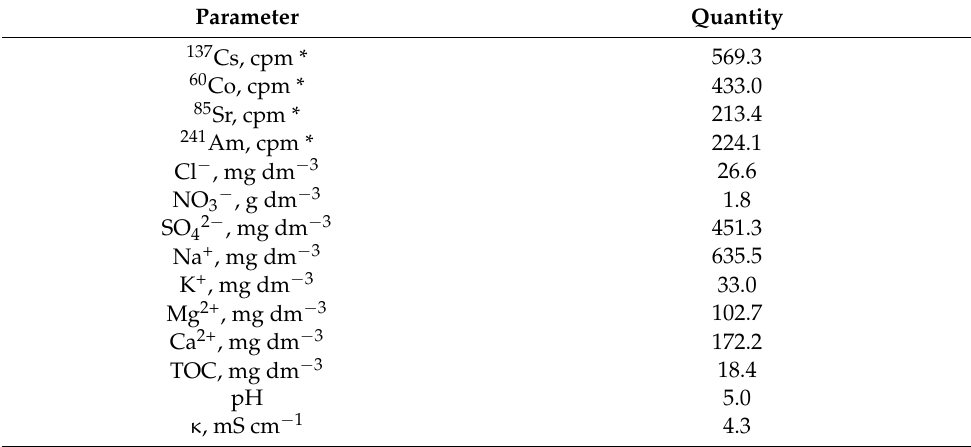
Table 6. Composition of the radioactive liquid waste